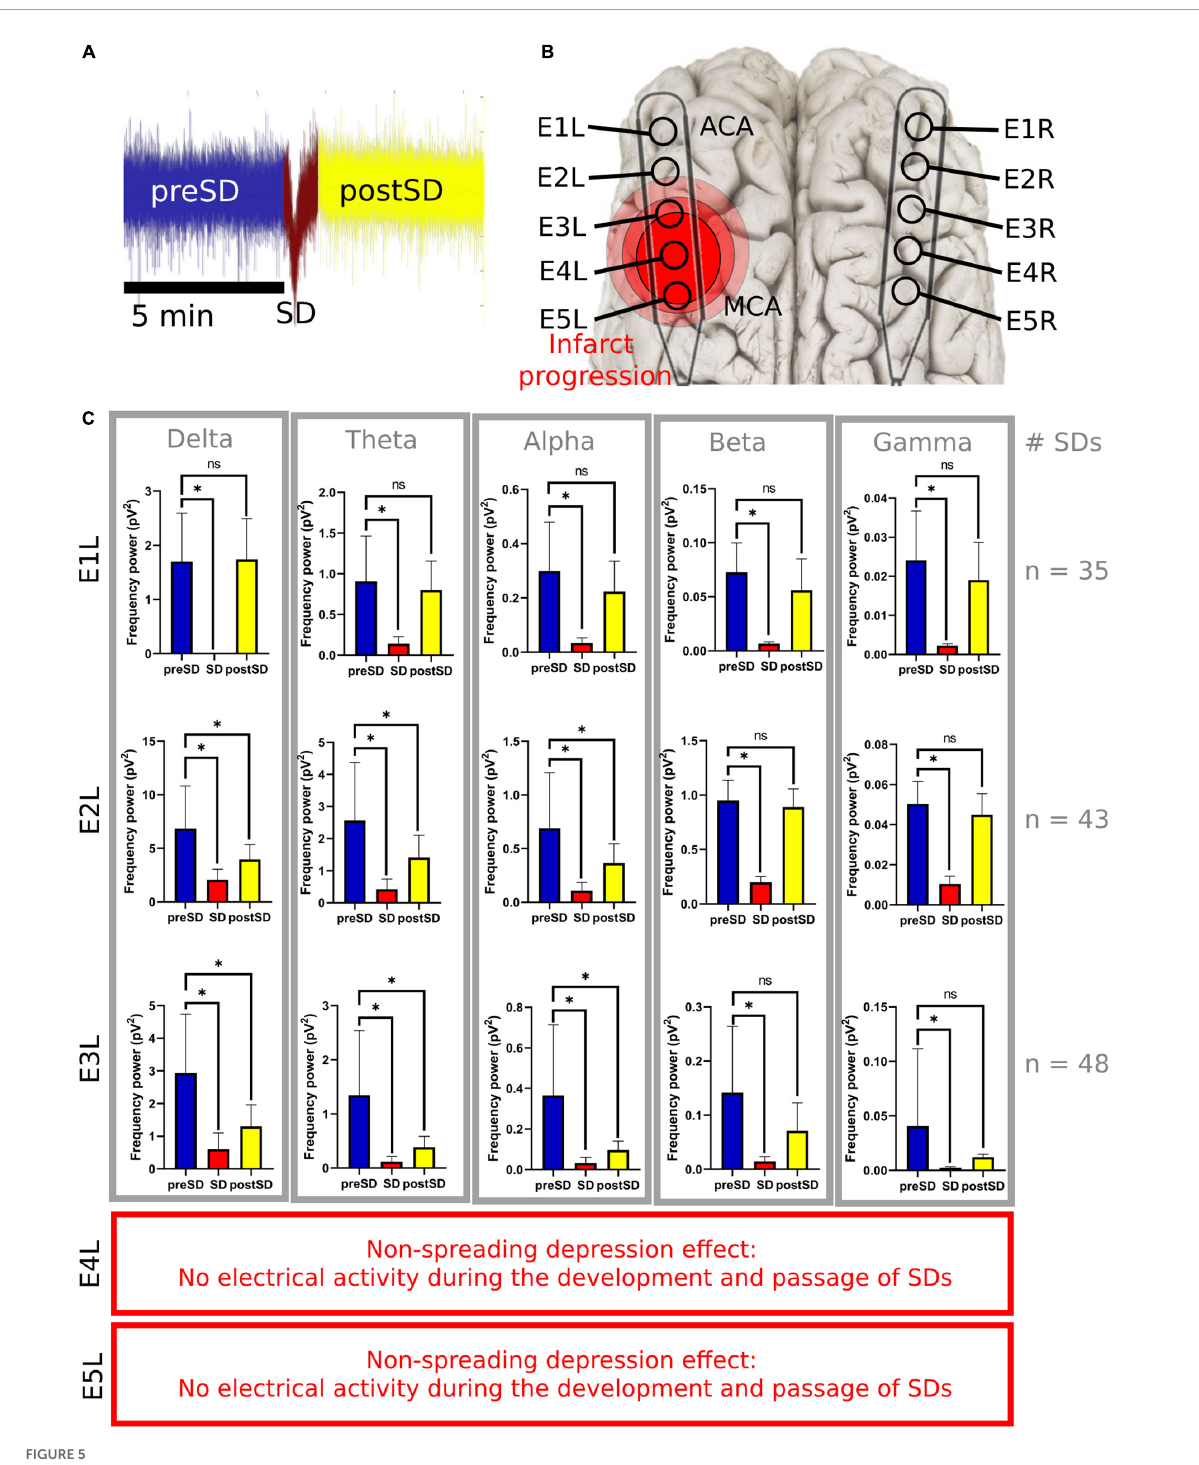
FIGURE5 Frequency bands in the left electrodes during and after SDs. (A) The 5-min signal segment before the SD (preSD) was used as the baseline to compare the variations in the spectral power during (SD) and after the SD (postSD) segments. Five minutes of the ECoG recording were used to analyze postSD. Meanwhile, the mean recording time of the near DC-shift of the SD was 51.3 s ( σ = ± 14.1s). (B) E1L was in the ACA territory and E5L was closer to the MCA territory. (C) Statistical analysis of SD segments: preSD was used as the baseline to compare the variations in the spectral power at SD and postSD segments, respectively. ∗ Statistically significant difference among SD segments ( p ≤ 0.05). E4L and E5L recorded isoelectric SDs with few or null electrical activities not relevant for the spectral power analysis of the frequency bands. SD, spreading depolarization; ECoG, electrocorticography; DC, direct current; ACA, anterior cerebral artery; MCA, middle cerebral artery; pV 2 , squared